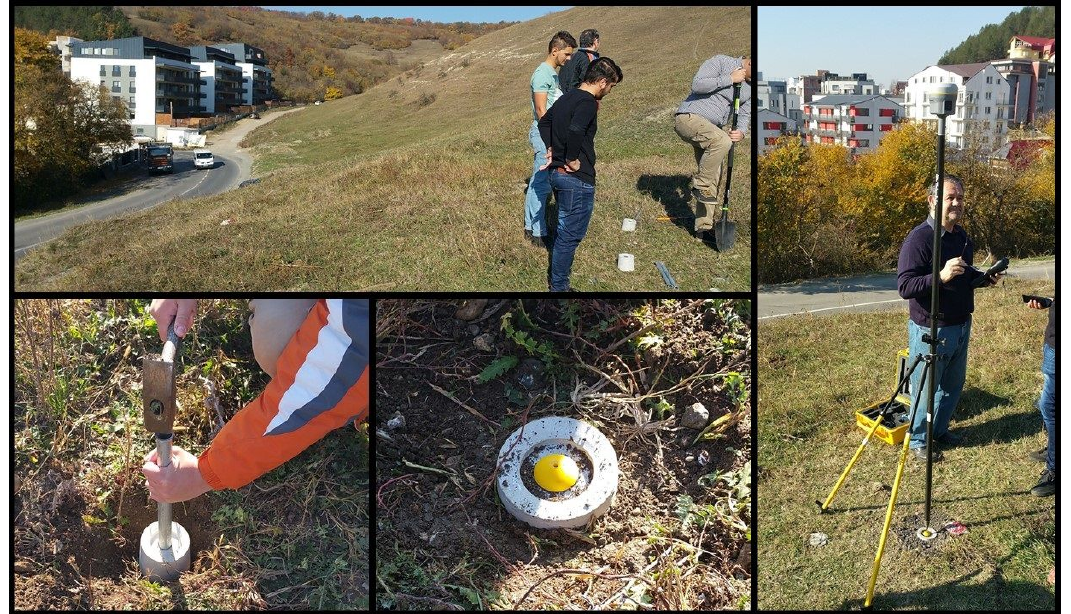
Figure 6. Established local geodetic network.